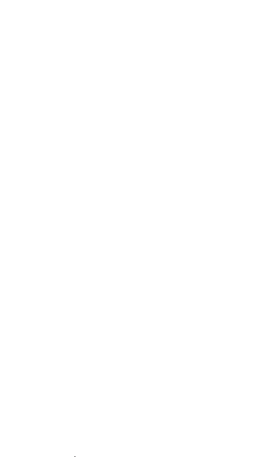
FIGURE 1 | HPGPC pro fi les